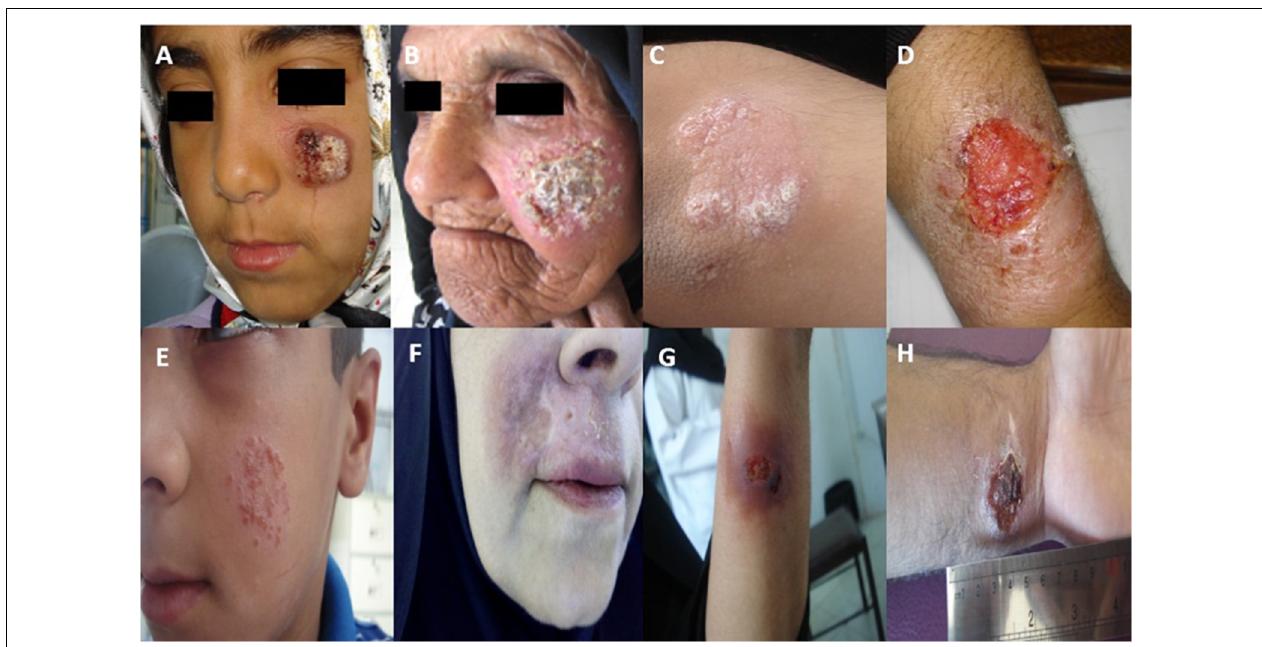
FIGURE 1 | Active lesions from different unresponsive patients (A–H) with ACL due to Leishmania tropica in Kerman, southeast Iran [images obtained from Bamorovat et al. (2018a, 2019a,b) and Aflatoonian et al. (2019)].